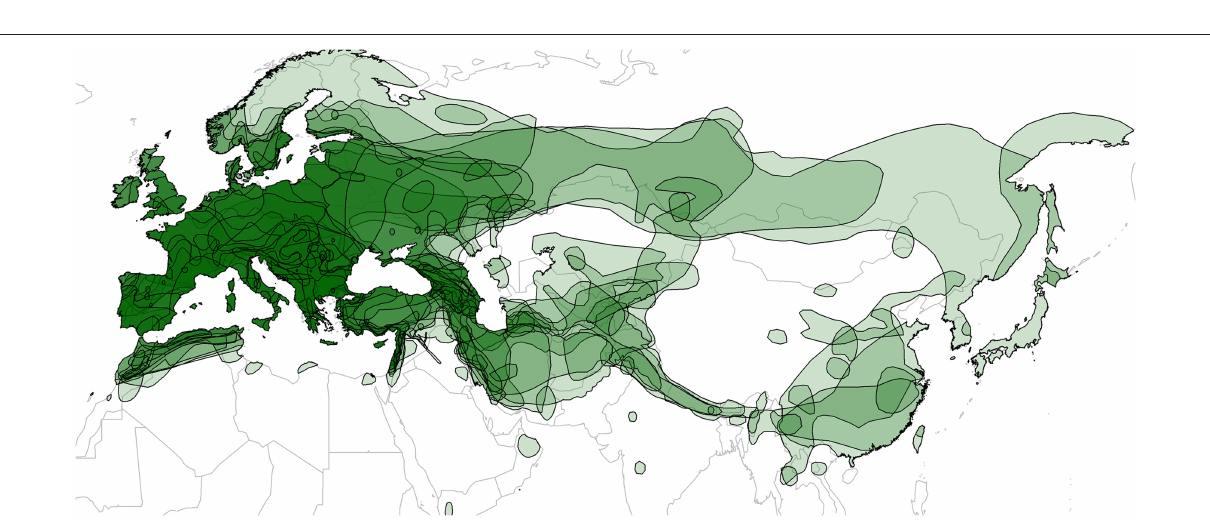
Belgium) together with Bartonella reference sequences available in